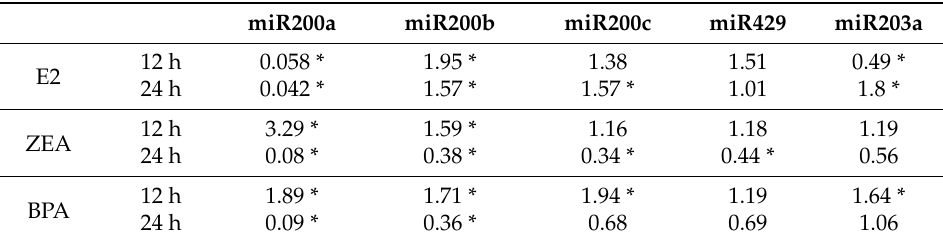
Table 3. Relative expression ratios of cell-free miR200s and miR203a after estrogen exposure in the PEO1 cell line. MiRNA was isolated from the supernatant of cell cultures 12 and 24 h after E2, ZEA and BPA treatments. Relative expression ratio was calculated relative to the expression value of miRNAs in the non-treated control (1). Ratio > 1 indicates upregulation relative to the non-treated control. Ratio < 1 indicates downregulation relative to the non-treated control. Significance was determined between the ΔCT values of treated and non-treated samples: * p < 0.05.